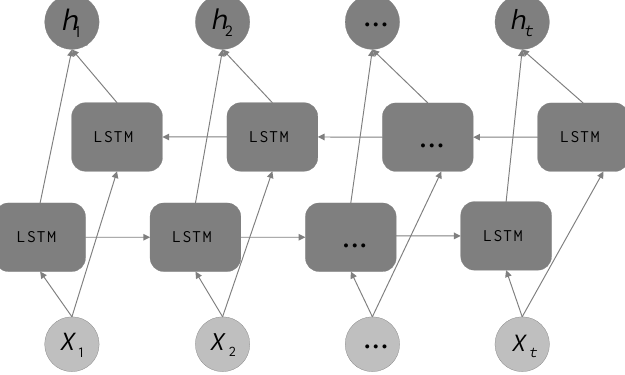
Figure A1. Maximum pooling process diagram.